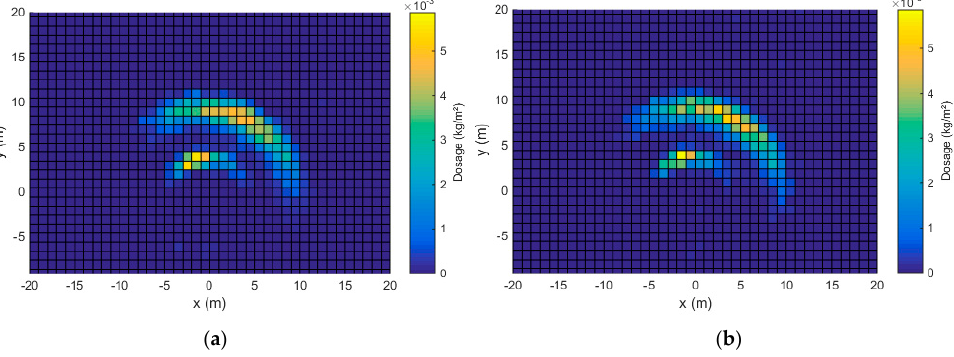
Figure 9. Static spread pattern, configuration A, test 1 ( a ) and test ( b ).